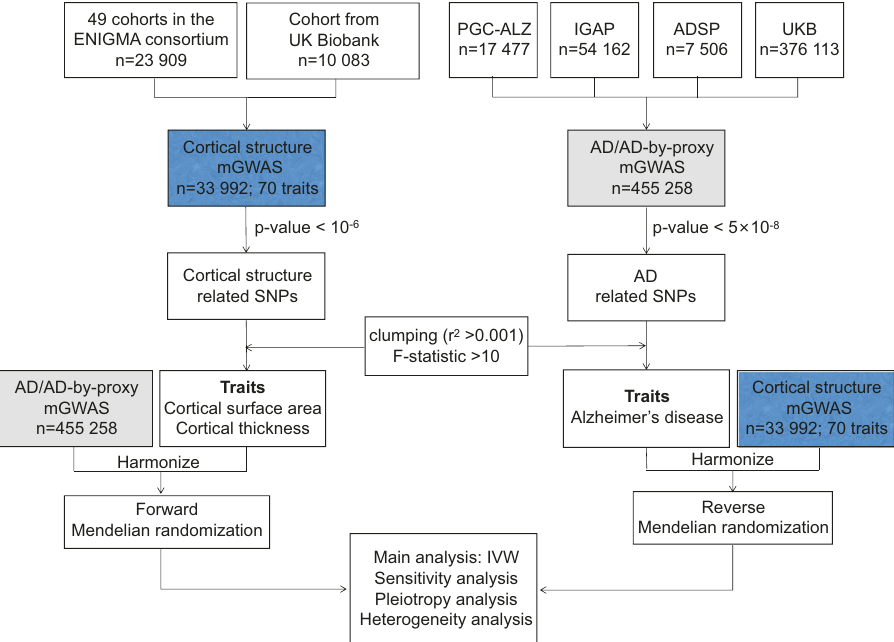
Fig. 1 Flowchart of our bidirectional two-sample Mendelian randomization analysis. AD Alzheimer ’ s disease, AD-by-proxy based on parental diagnoses, ADSP the Alzheimer ’ s Disease Sequencing Project, ENIGMA the Enhancing NeuroImaging Genetics through Meta-Analysis, IGAP the International Genomics of Alzheimer ’ s Project, IVW inverse-variance weighted, mGWAS meta-analysis of GWAS, PGC-ALZ Alzheimer ’ s Disease Working Group of the Psychiatric Genomics Consortium, SNP single-nucleotide polymorphism, UKB the UK